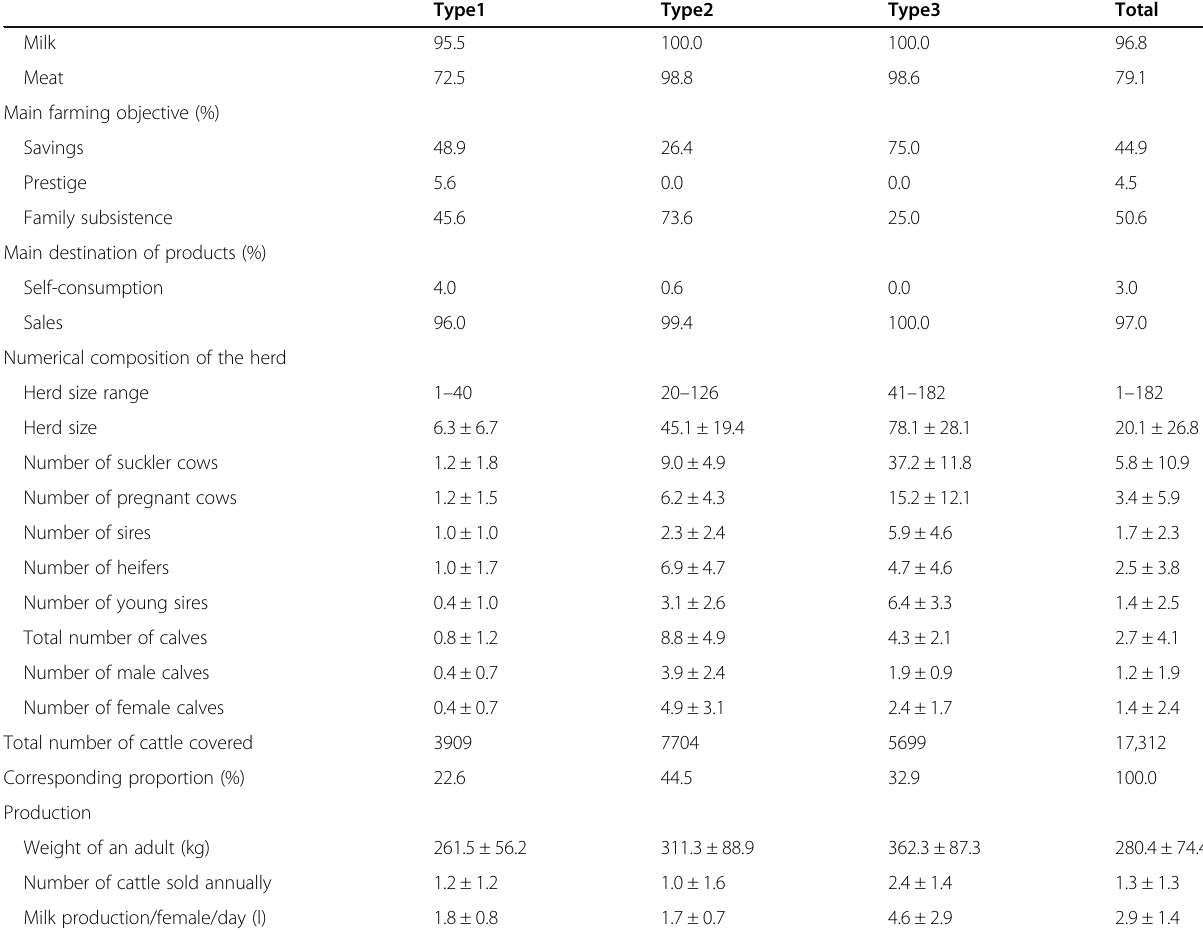
Table 2 Characteristics of cattle farm ’ s types